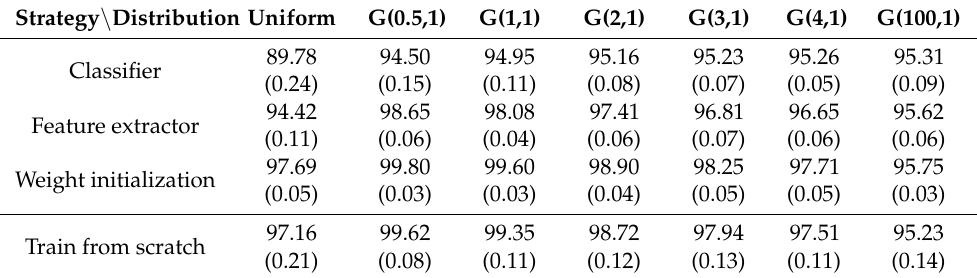
Table 9. Classification accuracies (%) of different transfer learning strategies.